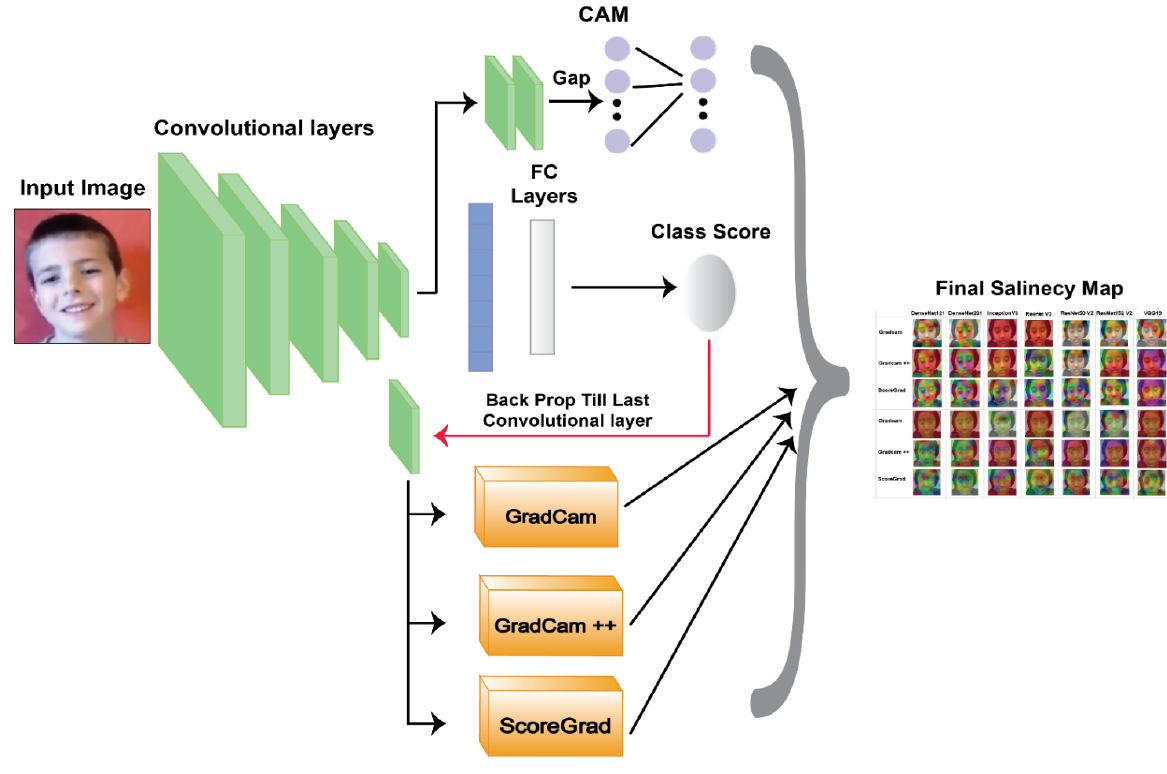
Figure 8. Explainable AI implementation.